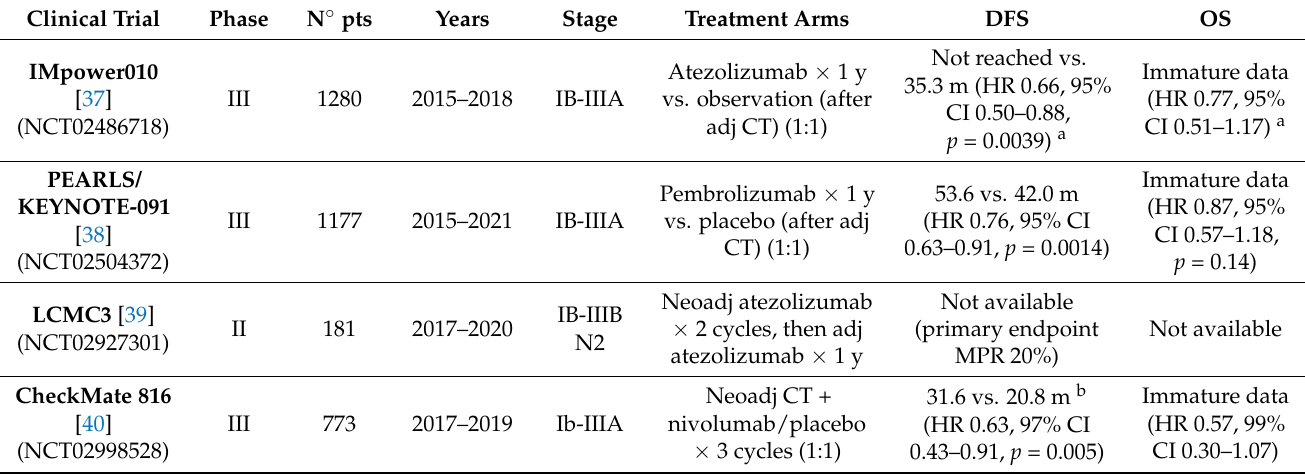
Table 5. Clinical trials with available data with ICIs in the (neo-)adjuvant